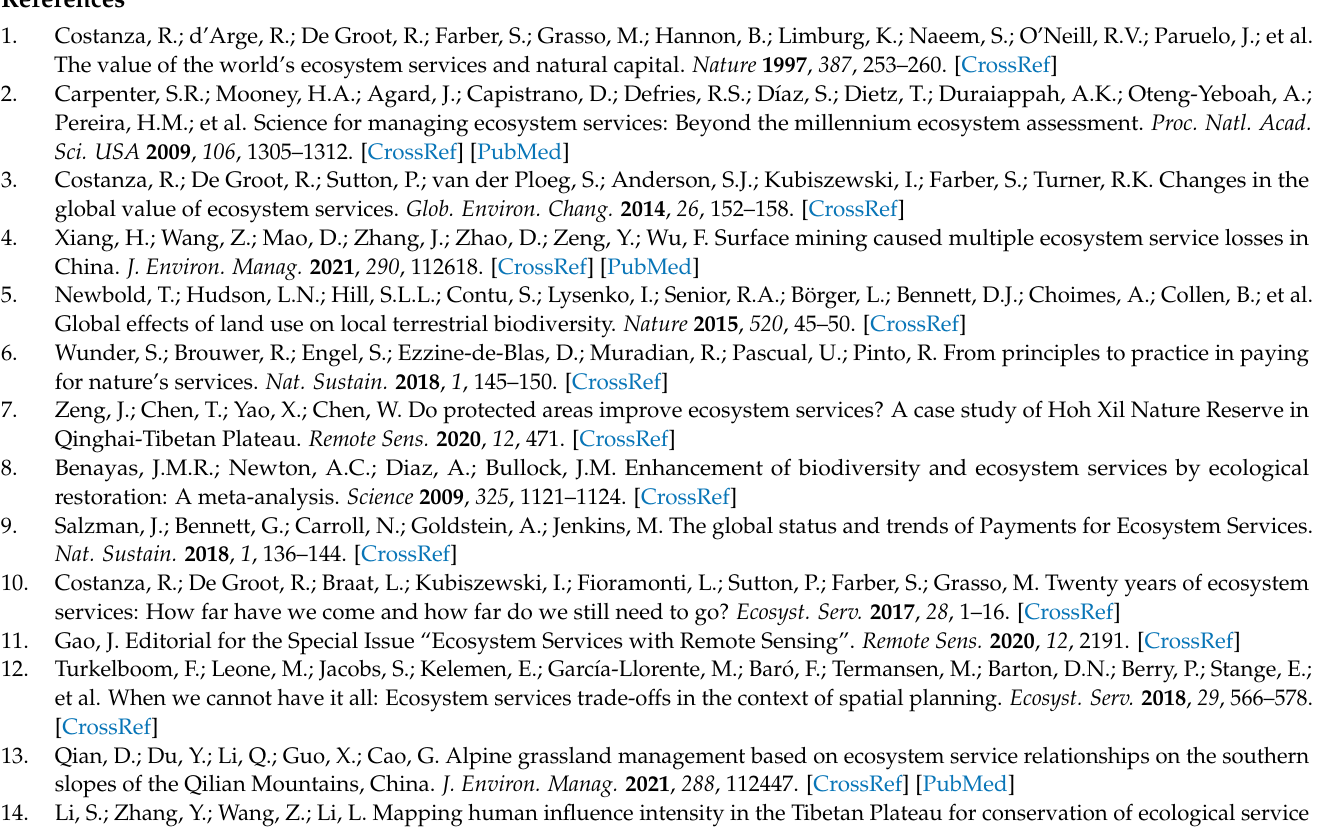
Table S2: The sensitivity of habitat types to each threat. Table S3: Table of biophysical coefficients for InVEST. Table S4: Description of variables selected in this study. Table S5: Multicollinearity test among influencing